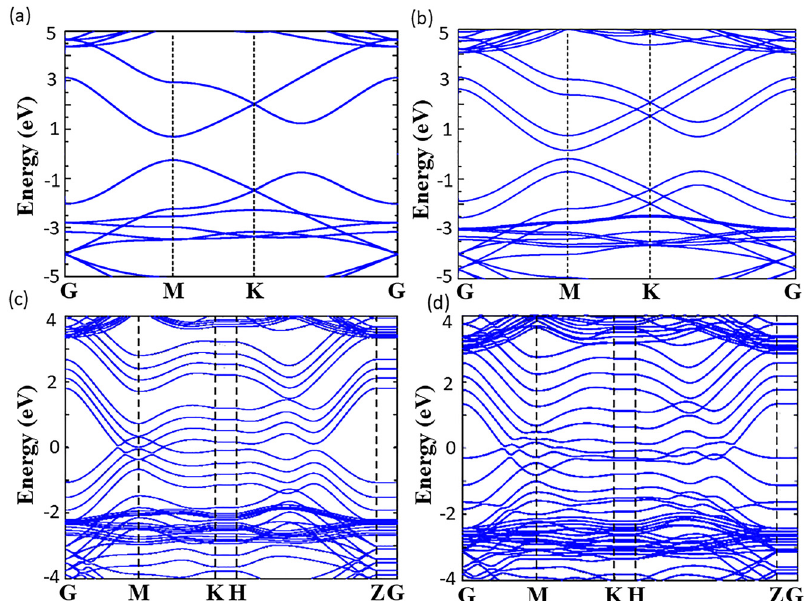
Figure1: Thebandstructureof(a)monolayer and (b) bilayer graphdiyne; the band structure of (c) four-layer graphdiyne with the adsorption of OH − and (d) without the adsorption of OH −